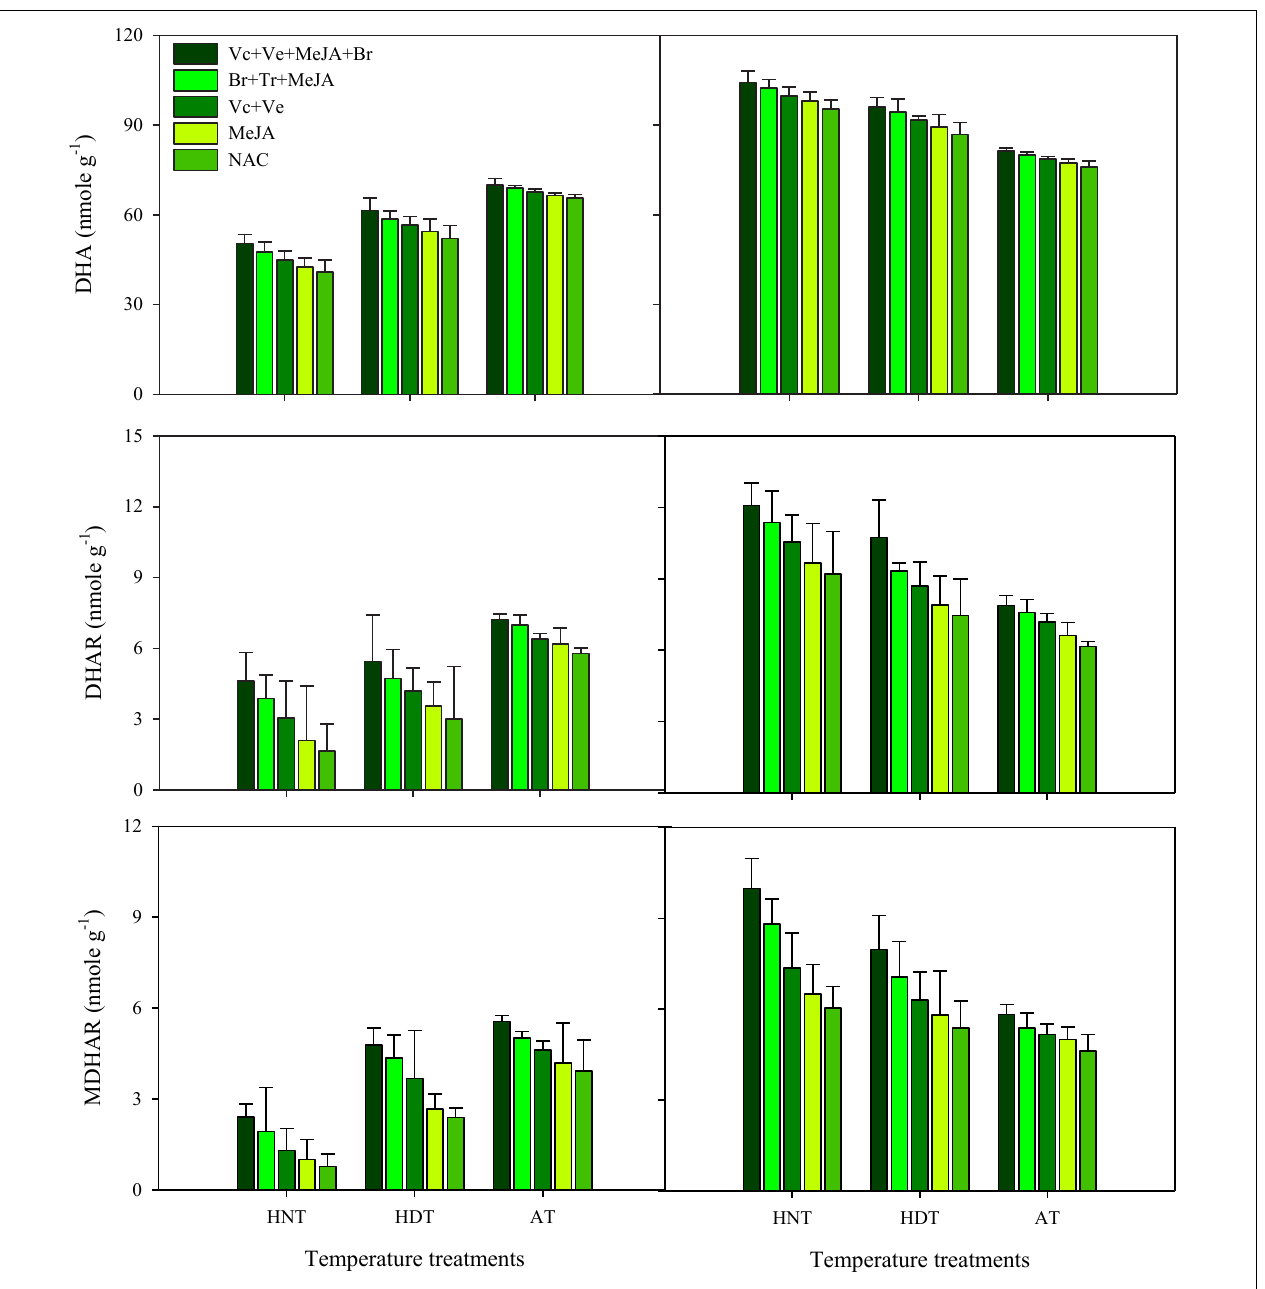
FIGURE 5 | Monodehydroascorbate reductase (MDHAR), dehydroascorbate (DHA), and dehydroascorbate reductase (DHAR) concentration in rice leaves as affected by growth regulators under heat stress. HDT, HNT, and AT stand for high day, high night, and ambient temperature, respectively. The lines on bars represent LSD value for the interaction of PGRs and heat stress (heat stress × PGR) at α =